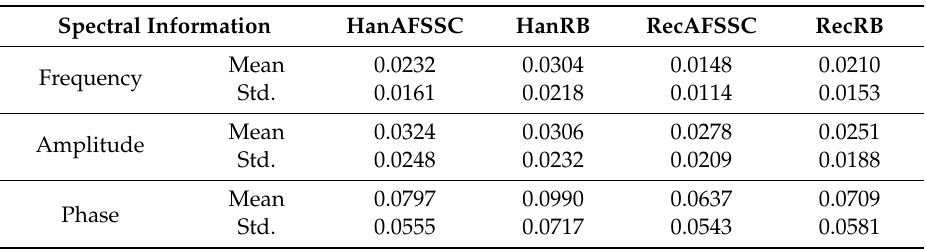
Table 3. Comparisons of the four techniques when f c = 250.01Hz.